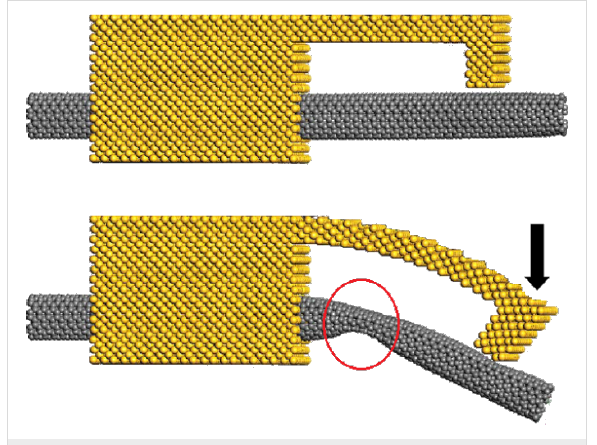
Figure 2: Electrostatic actuation of a CNT that conveys a fluid (top: “open”, bottom: “closed).